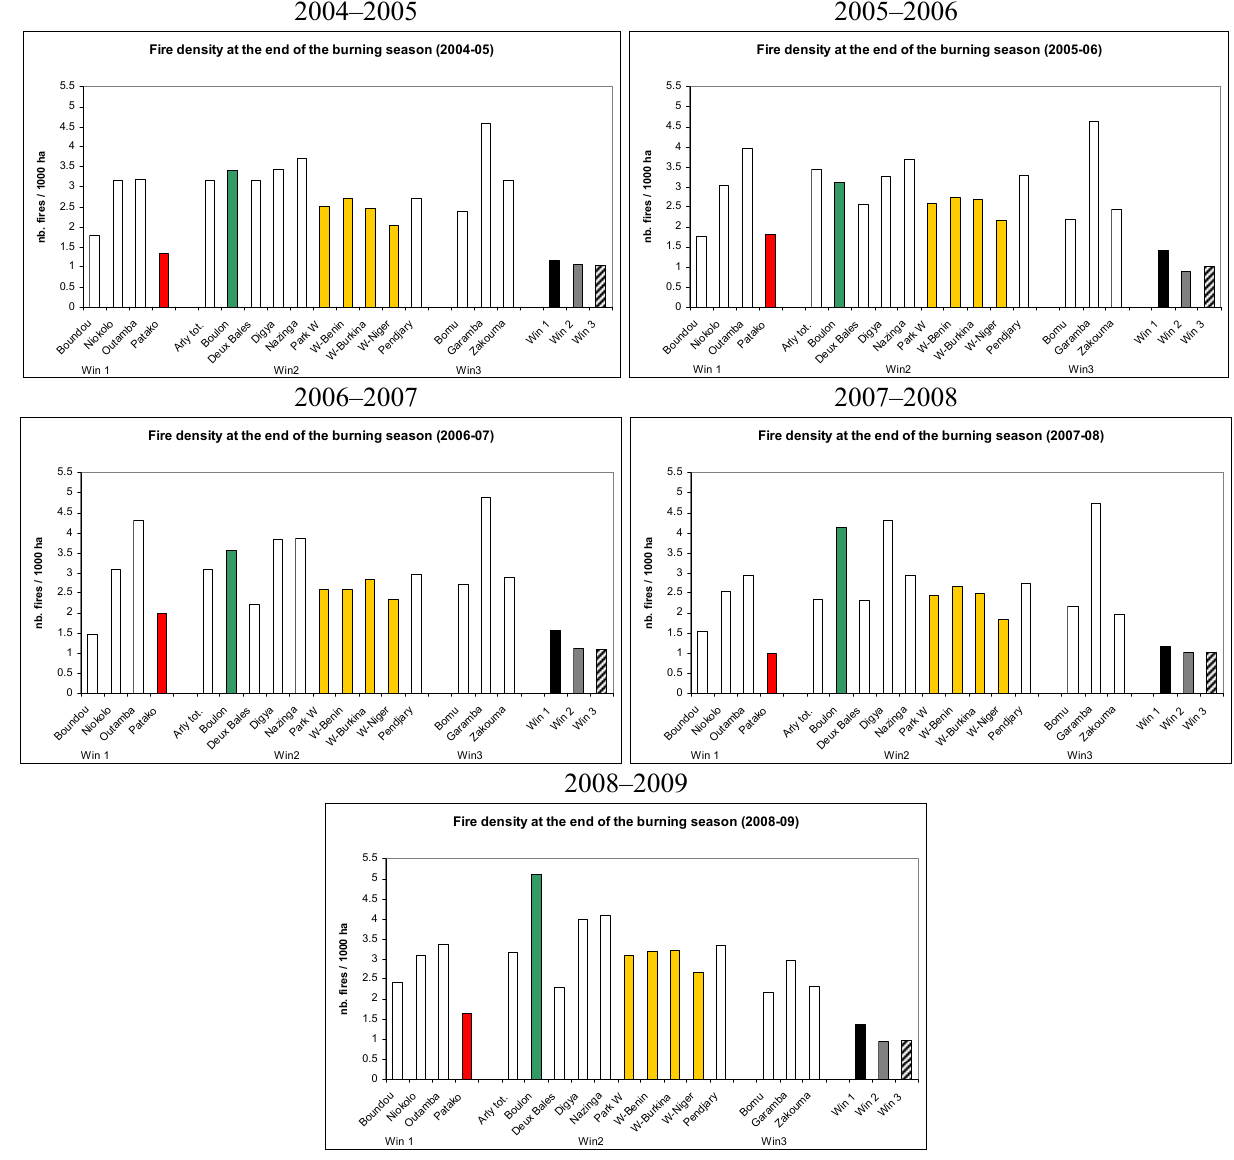
Figure 4. Fire density (nb. fire pixels/1,000 ha) in Patako (red), Boulon (green), Park W (orange) and other 11 protected areas of West and Central Africa from 2004 to 2009. Fire density in the regional windows: window 1 (black), 2 (grey) and 3